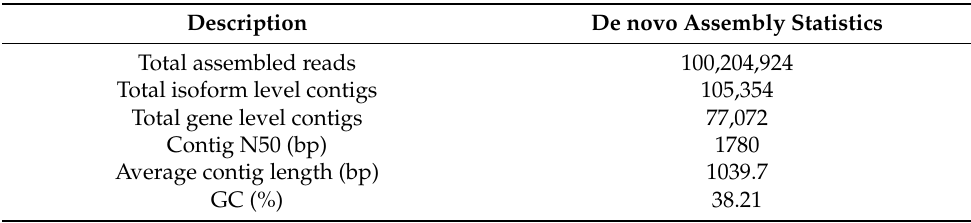
Table 1. Statistics of Illumina sequencing and de novo transcriptome analysis in C. canadensis . The de novo transcriptome was assembled from a total of 24 libraries of TNR and TNS biotypes, with and without glyphosate